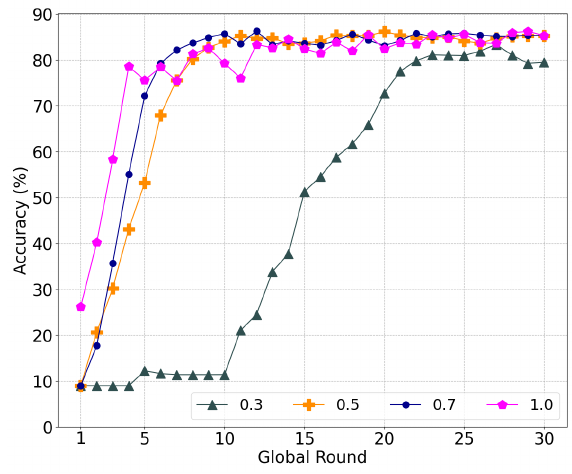
Figure 9. The accuracy of a global model depends on the adjustment of β